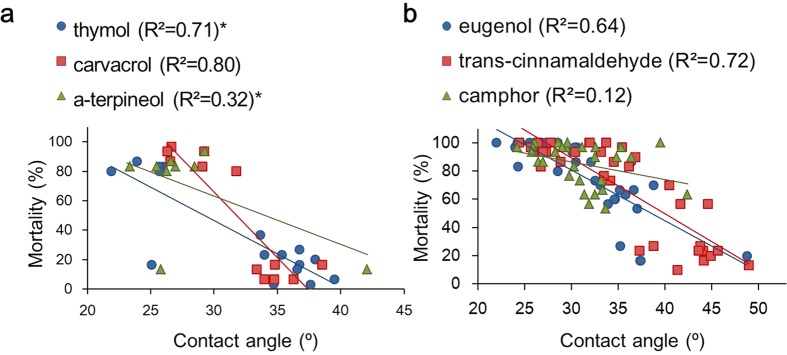
Interactions between mortality in the topical application and contact angles on a beeswax layer of selected mixtures.(a) The synergistic and antagonistic binary mixtures of group A compounds (thymol, carvacrol and α-terpineol) at LD50 and an equivalent amount of blending compounds, (b) the binary mixtures of group B compounds (eugenol, trans-cinnamaldehyde and camphor) at LD20 + LD20 with other compounds. *When camphene was excluded, the R2 values of thymol and α-terpineol increased to 0.91 and 0.83, respectively.